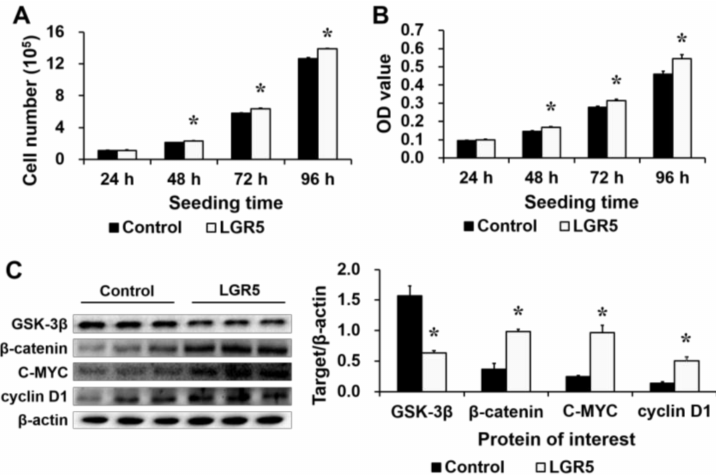
Figure 4. The effects of LGR5 overexpression on cell proliferation and WNT/ β -catenin signaling-related protein expression in IPEC-J2 cells. ( A ) The cell number was higher in the LGR5 -overexpressing group than in the control group at 48, 72 and 96 h after seeding, as assessed by the cell count assay ( m); ( B ) The optical density (OD) value was higher in the LGR5 -overexpressing group than in the control group at 48, 72 and 96 h after seeding, as assessed by the MTT assay ( n = 20); and ( C ) The levels of WNT/ β -catenin signaling-related proteins were assessed by Western blot ( n = 3). The results were confirmed by three independent experiments per treatment. Representative results of the three independent experiments are shown. The bars are the means ± SE, * indicates a significant difference ( p < 0.05).